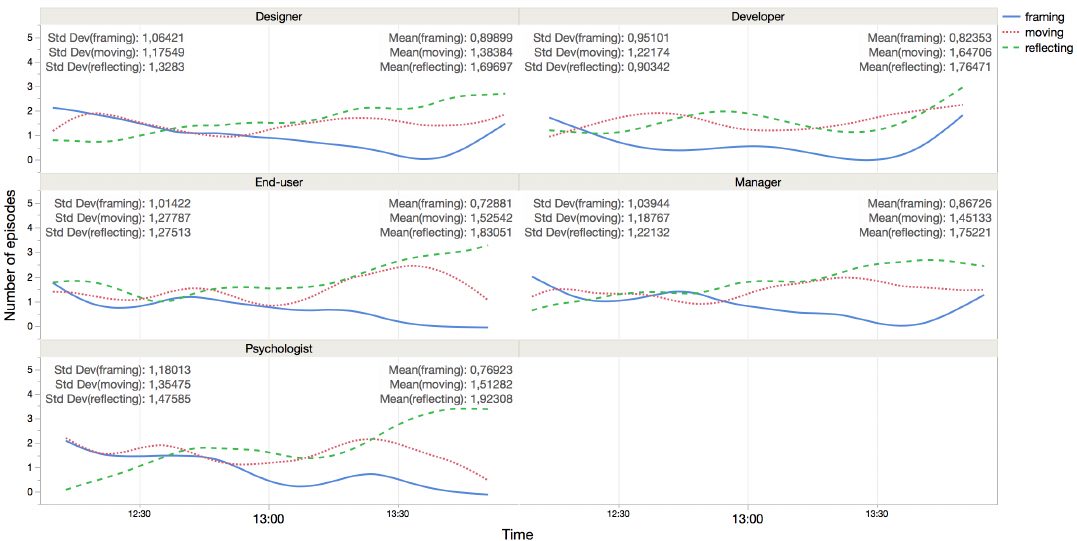
Figure 9. Episodic activity across disciplines, without